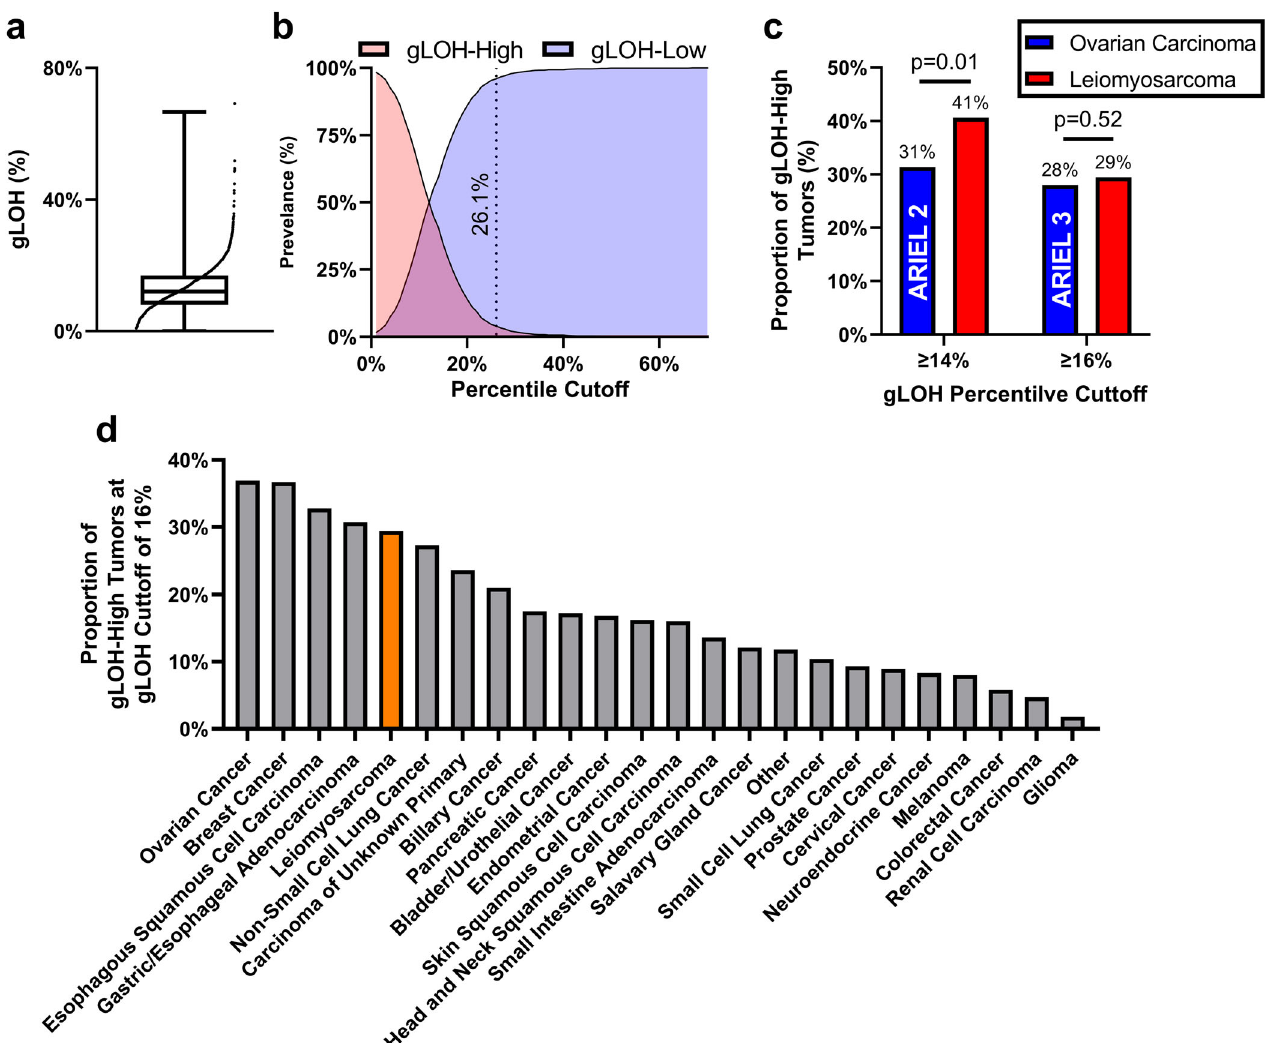
Fig. 1 Distribution of gLOH in LMS. a LMS tumors display a mean gLOH of 12.9% and a log-normal distribution. Boxplot elements: center line — median, bounds of box — inter quartile rage, whiskers — minimum and maximum. b Prevalence of gLOH-High and gLOH-low tumors across the dataset identi fi ed an in fl ection point at 26.1%. c Compared to ovarian carcinoma from the ARIEL2 and ARIEL3 trials 20,25 , LMS demonstrated a higher or equal proportion of gLOH-High tumors at a gLOH cutoff of 14% and 16%, respectively. d Across a variety of